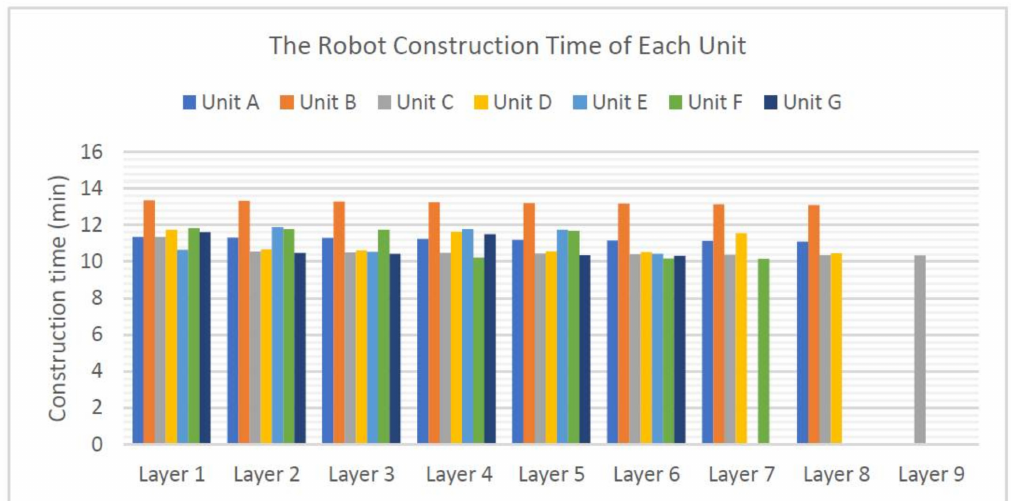
Figure 13. The layer construction time of each unit by robot